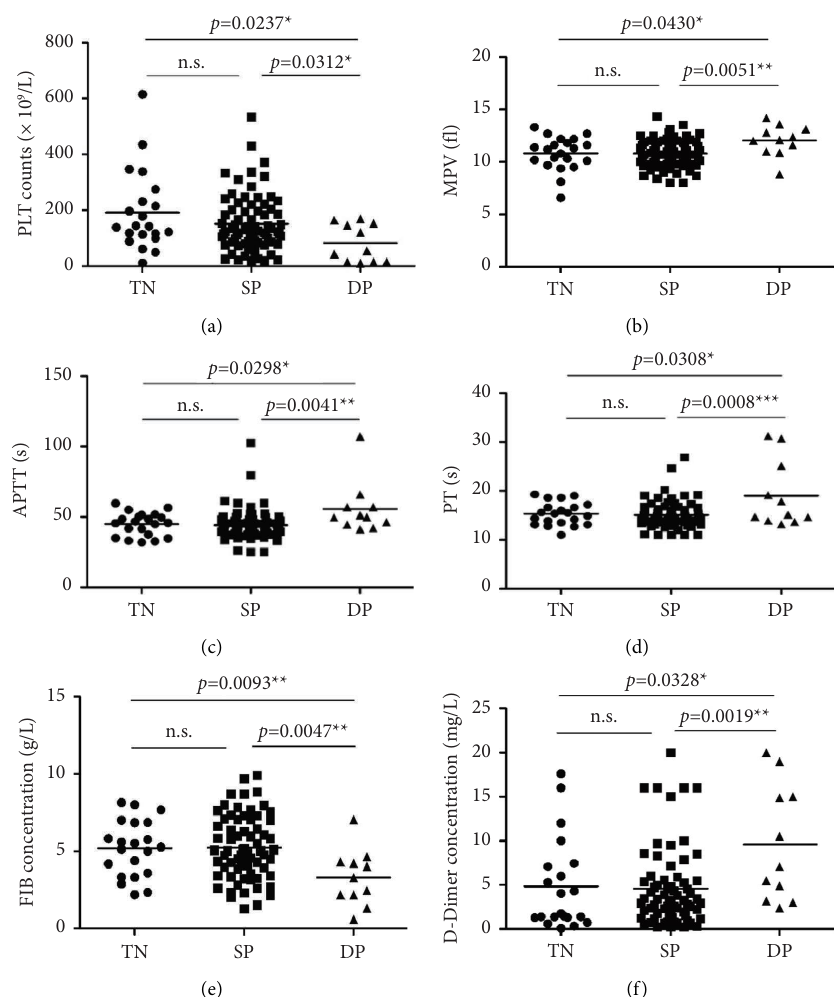
Figure 7: Comparison of peripheral blood coagulation indexes in patients infected with S. aureus with diferent virulence